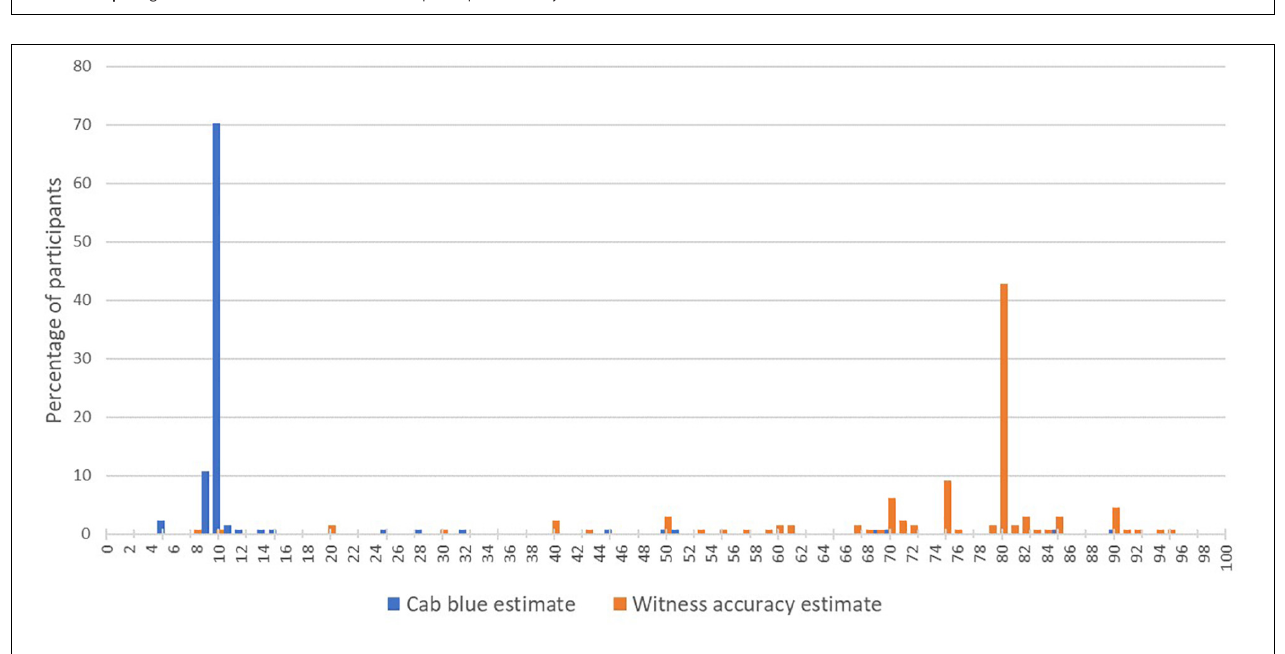
FIGURE 6 | A histogram representing participant prior estimates of the probability the cab is blue (blue) and witness accuracy (orange).